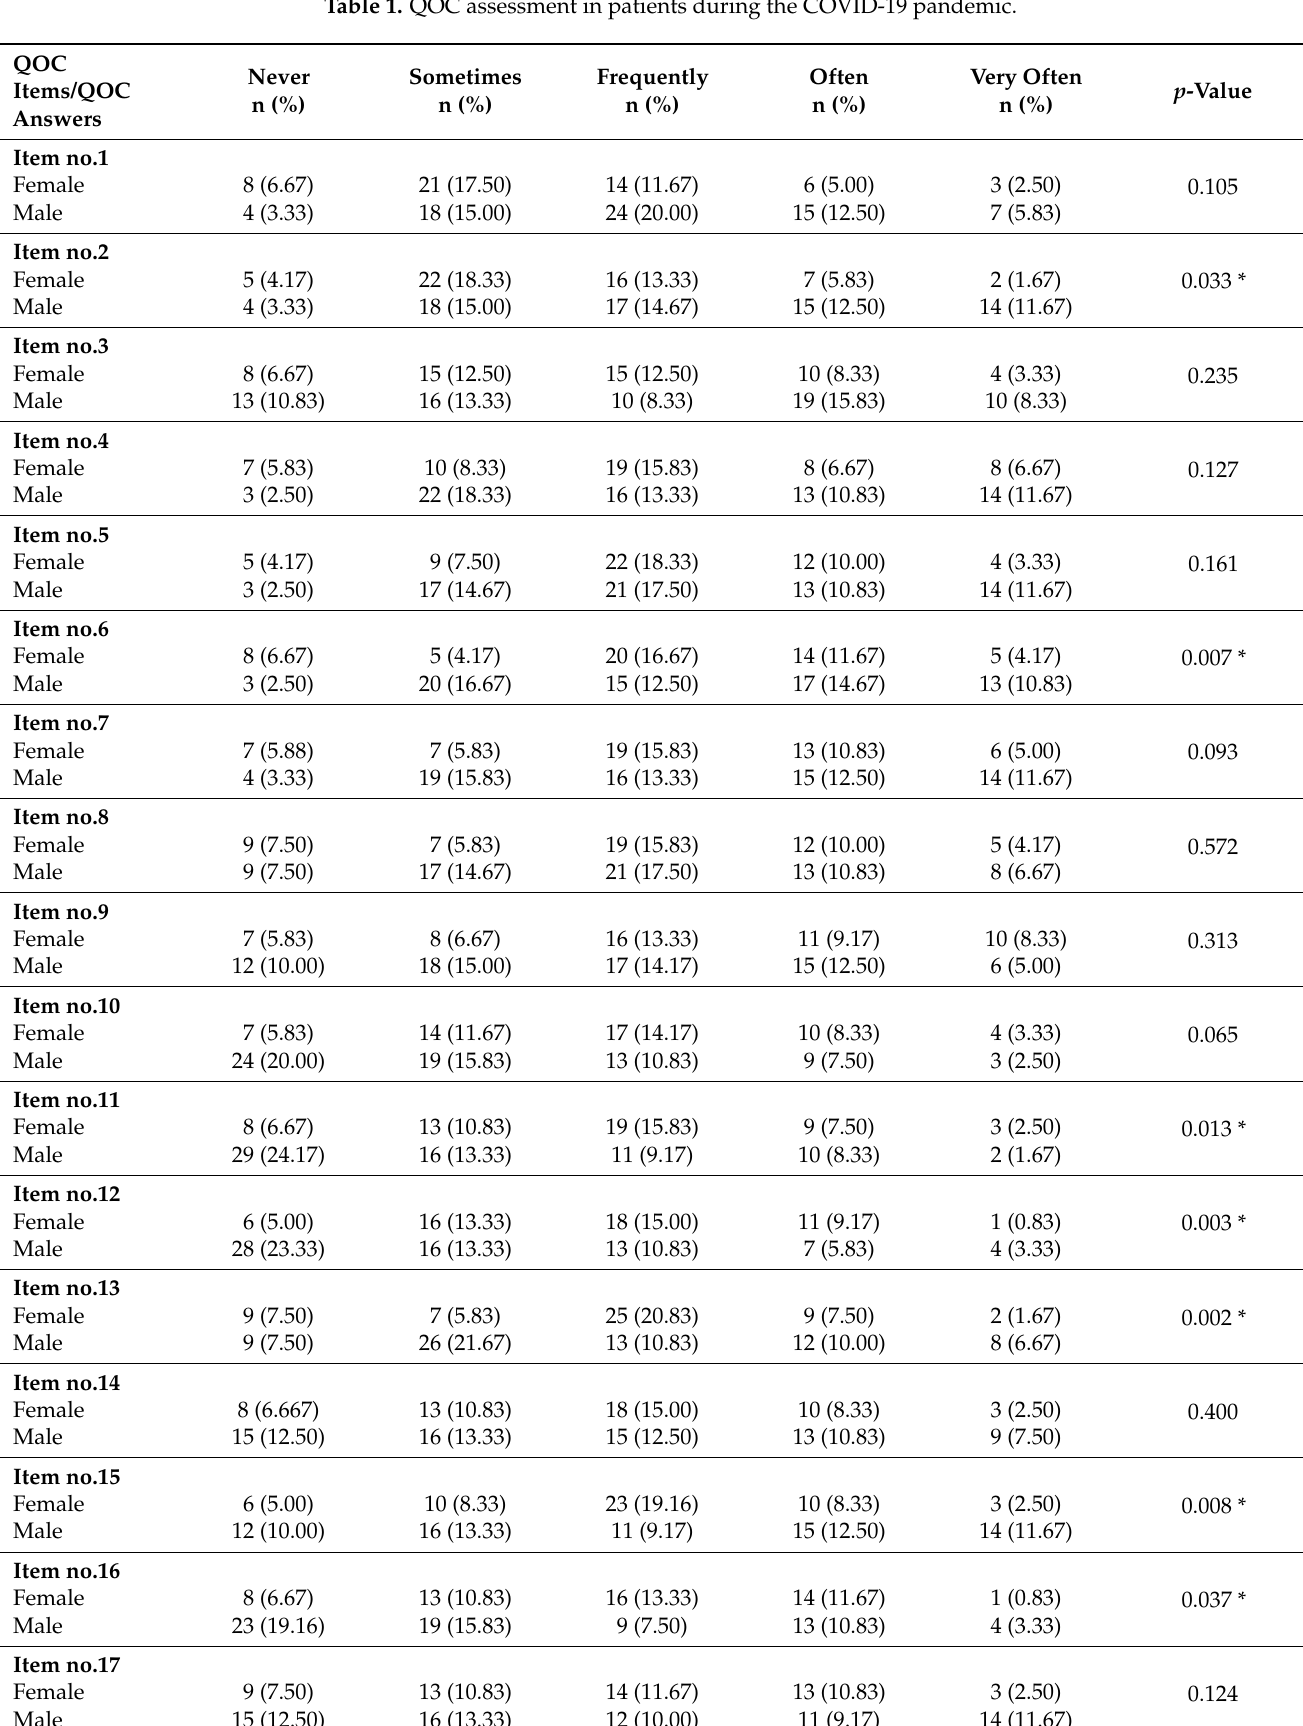
Table 1. QOC assessment in patients during the COVID-19